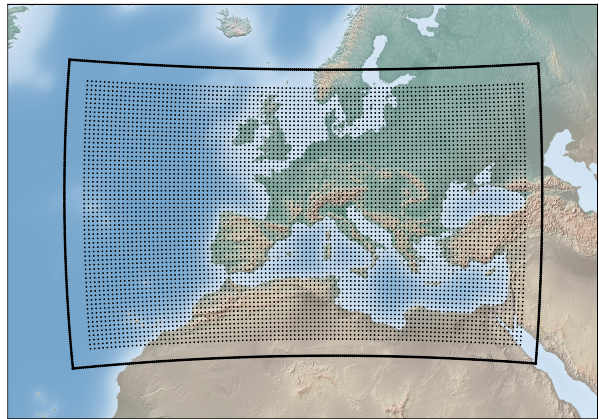
Figure 1. Model domain of the COSMOiso simulation (black line) and the starting points of the backward trajectories